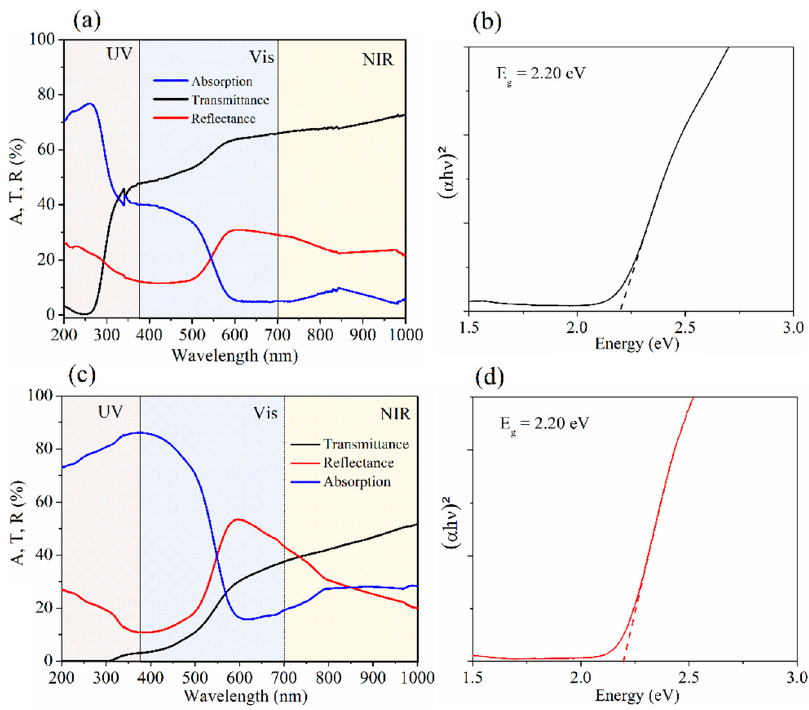
Figure 6. Absorption, transmittance, and reflectance of BiFeO 3 deposited on a glass substrate with ( a ) no second milling, ( c ) with 8 h of second milling of the initial powder. Their respective Tauc plots are illustrated in ( b , d ).